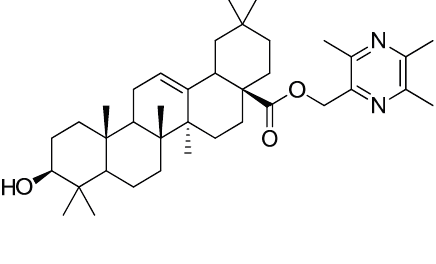
Figure 1. Structure of